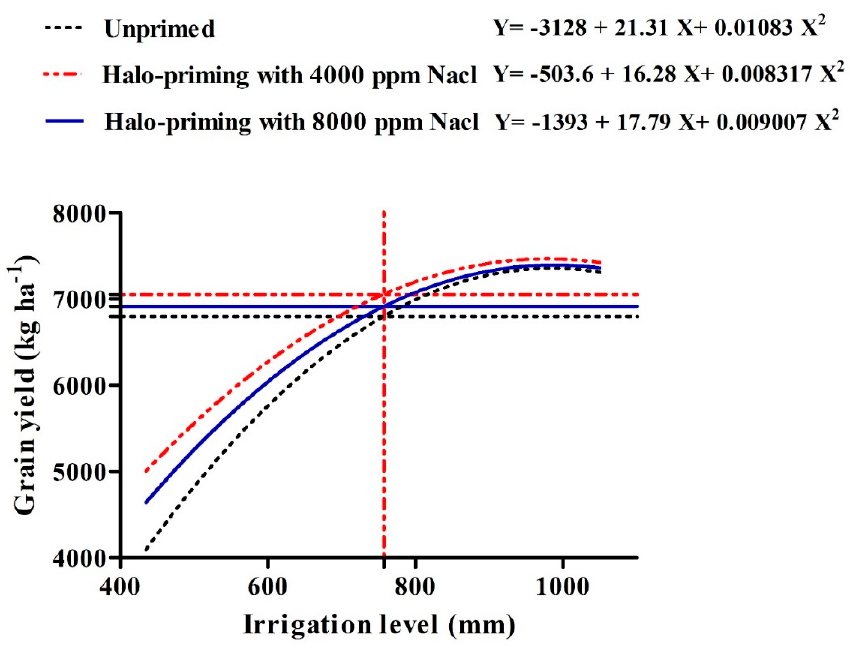
Figure 4. Response of grain yield to irrigation regimes and determining minimum irrigation amount to produce economic grain yield for the three priming treatments.